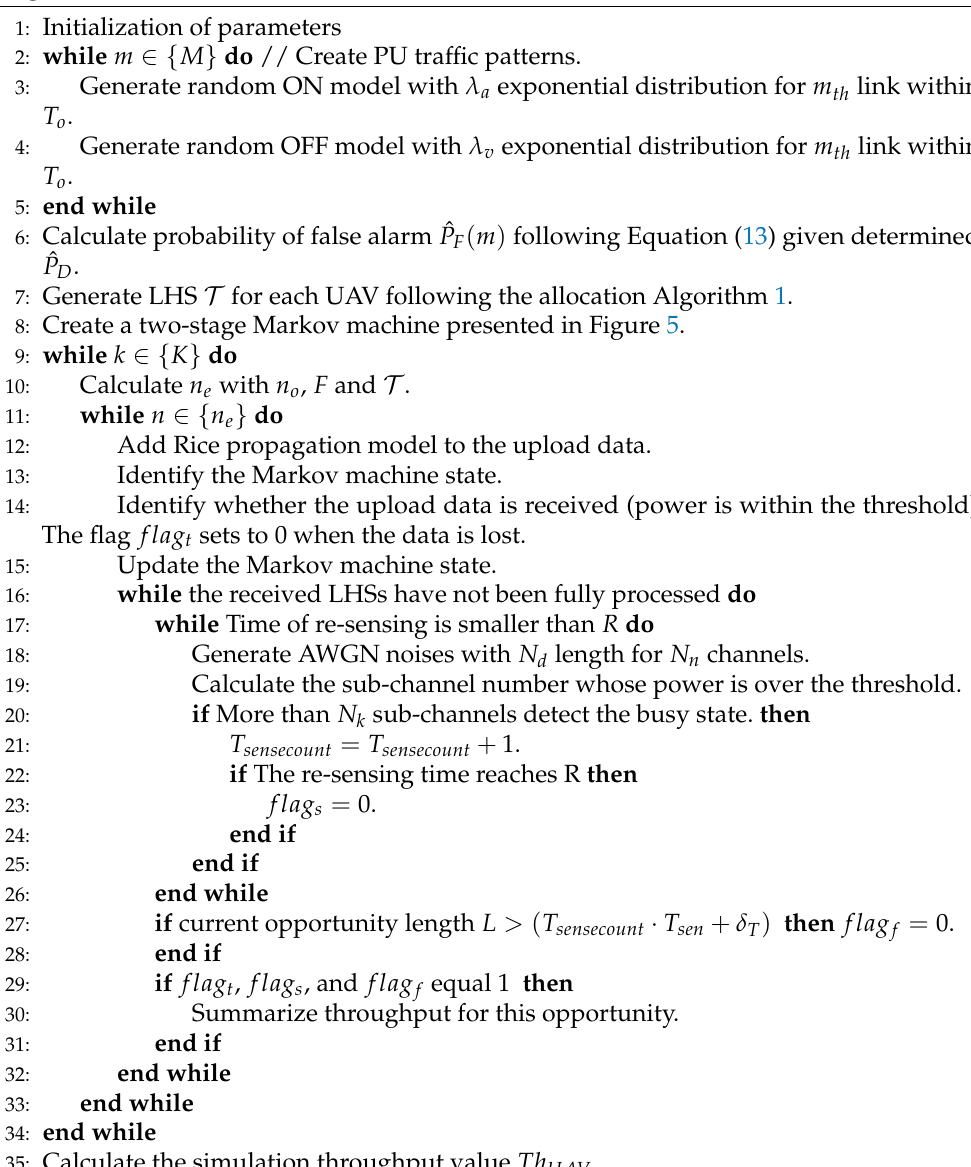
Algorithm 2 Pseudo-code of RA-OLA Scheme for Random PU Traffic